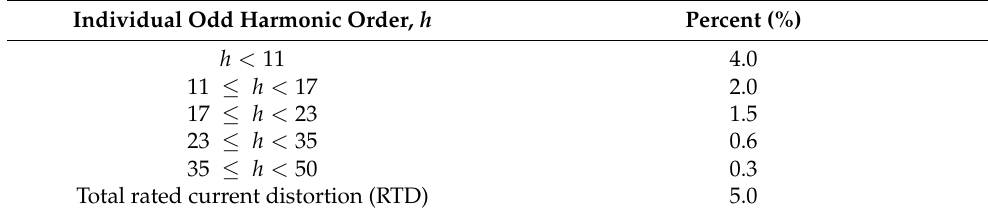
Table A3. IEEE 1547 Maximum odd harmonic current distortion in percent of rated current.